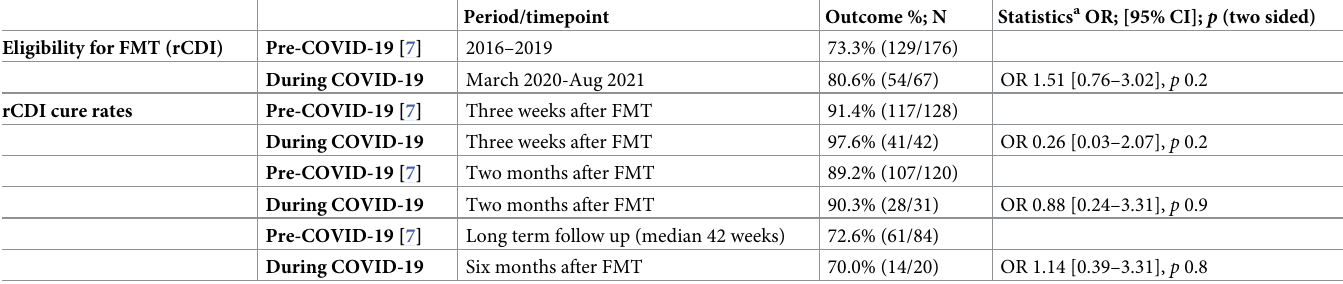
Table 3. Eligibility for FMT and cure rates of FMT for rCDI during versus before the COVID-19 pandemic.